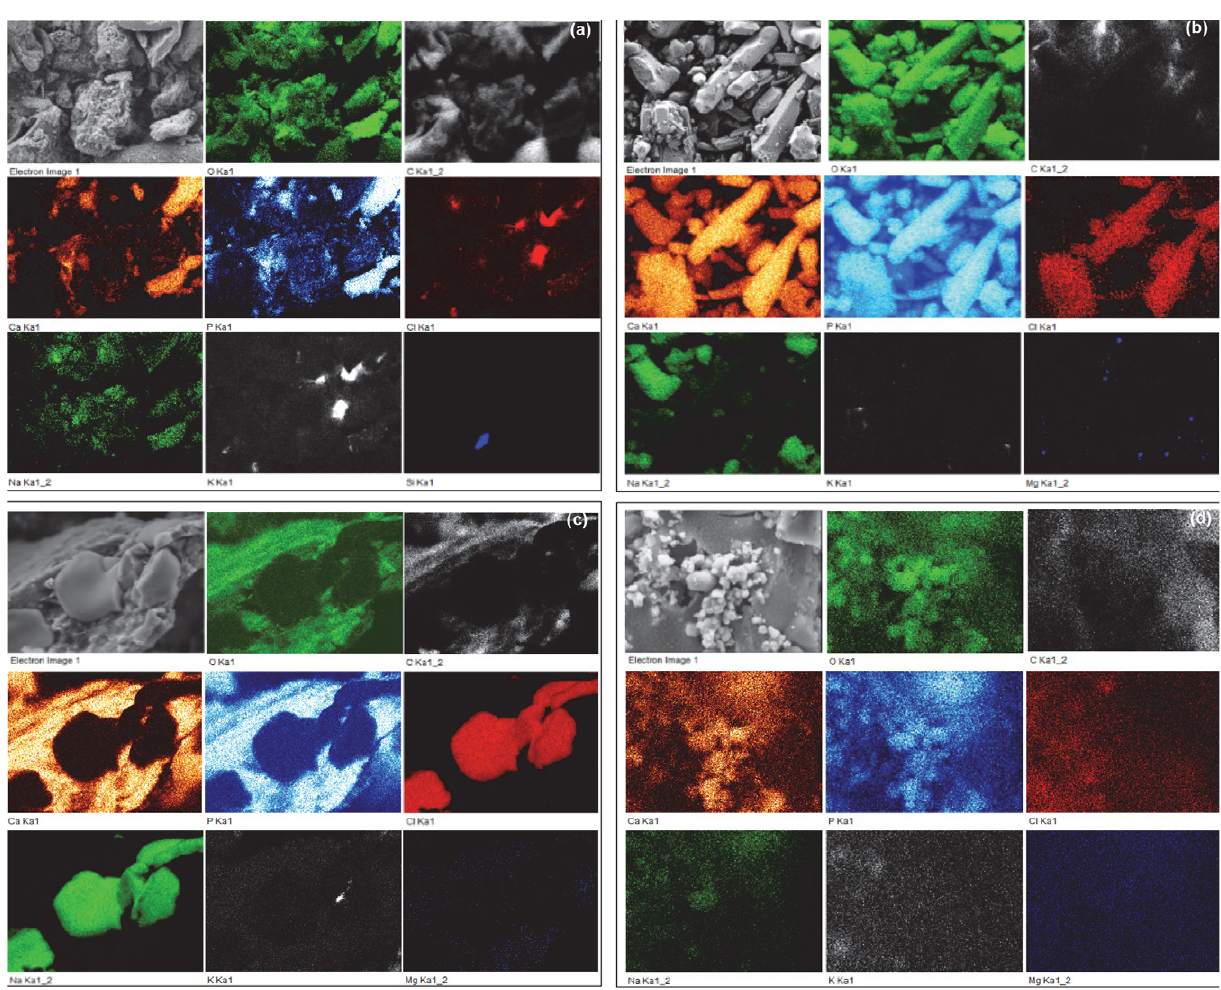
Figure 9. EDS maps of elemental distribution in the samples T1H005 (a), T2H005 (b), T1H100 (c) and T2H100 (d). Distribution of the elements from left to right for all samples: upper line – electron image, oxygen, carbon; in the middle – calcium, phosphorus, chlorine; bottom line – sodium, potassium, magnesium or silicon (sample